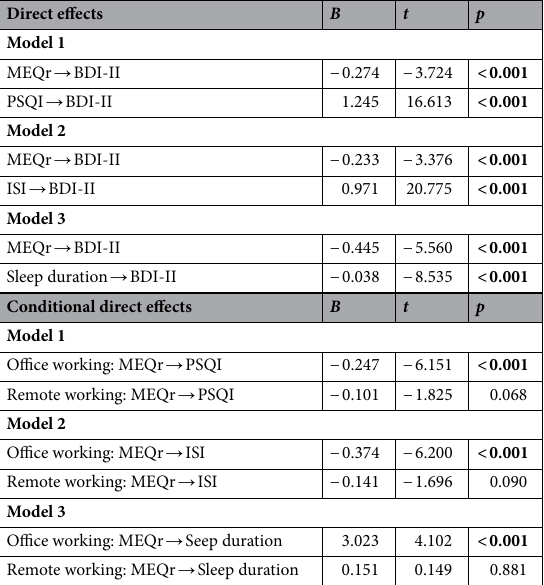
Table 3. Direct effects and conditional direct effects at the value of the moderator (office working, remote working) for the three models, including sleep quality (PSQI score; Model 1), insomnia symptoms (ISI score; Model 2), and sleep duration (min; Model 3) as mediators, whilst accounting for the effects of age and gender. PSQI Pittsburgh sleep quality index, ISI insomnia severity index, MEQr morningness-eveningness questionnaire-reduced version, BDI-II beck depression inventory-second edition. Significant values are in